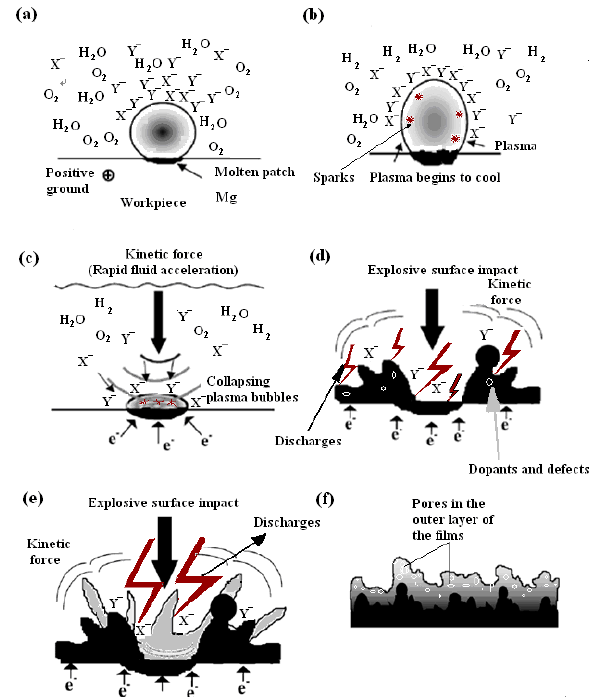
Figure 8. The heat and mass transfer models during the PEO process. X − , Y − —represents anions; e  —represents electrons. ( a ) the conventional anodic oxidation stage ( b – c ) the transition stage ( d – f ) the discharge